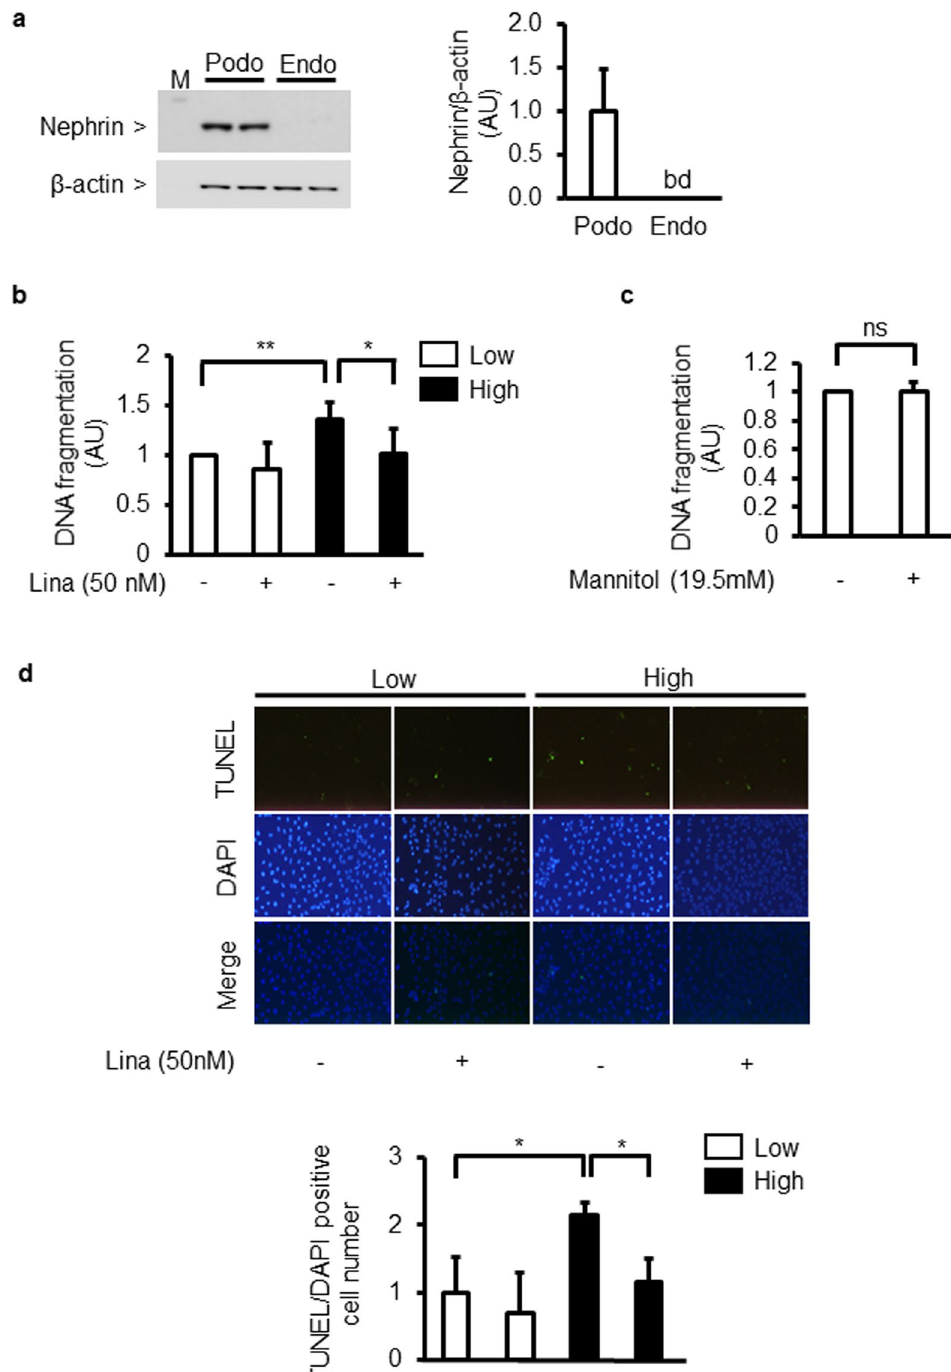
Figure 1. Effect of high glucose and linagliptin on apoptosis in cultured podocytes. ( a ) Immunoblot analyses of nephrin in cultured podocytes and endothelial cells. Podo; podocytes. Endo; endothelial cells. bd; below detection limit. ( b ) DNA fragmentation in podocytes incubated with low glucose (5.5 mM) or high glucose (25 mM) for 96 h in the absence or presence of linagliptin (50 nM). Lina; linagliptin. * P < 0.05. ** P < 0.01. ( c ) Effect of D-mannitol-induced hyperosmolality on DNA fragmentation. Low; low glucose. High; high glucose. Lina; linagliptin. ns; not significant. ( d ) Immunocytochemical staining with TdT-mediated dUTP nick end (TUNEL) and 4 ′ ,6-diamino-2-phenylindole (DAPI) (merged image). Magnification: X40. Low; low glucose. High; high glucose. Lina; linagliptin. * P < 0.05. These data are expressed as means ± SD. Results are representative of one of three independent